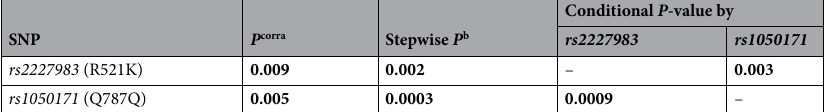
Table 3. Independent association signals among glioma-associated EGFR variants. The P -values were obtained by logistic analysis between glioma patients (n = 324) and PCs (n = 480) under addictive model. Significant associations are shown in bold face. a Bonferroni-adjusted P -values by 13 SNP tests. b The significance level was set at 0.05 in stepwise selection of glioma-associated EGFR SNPs.